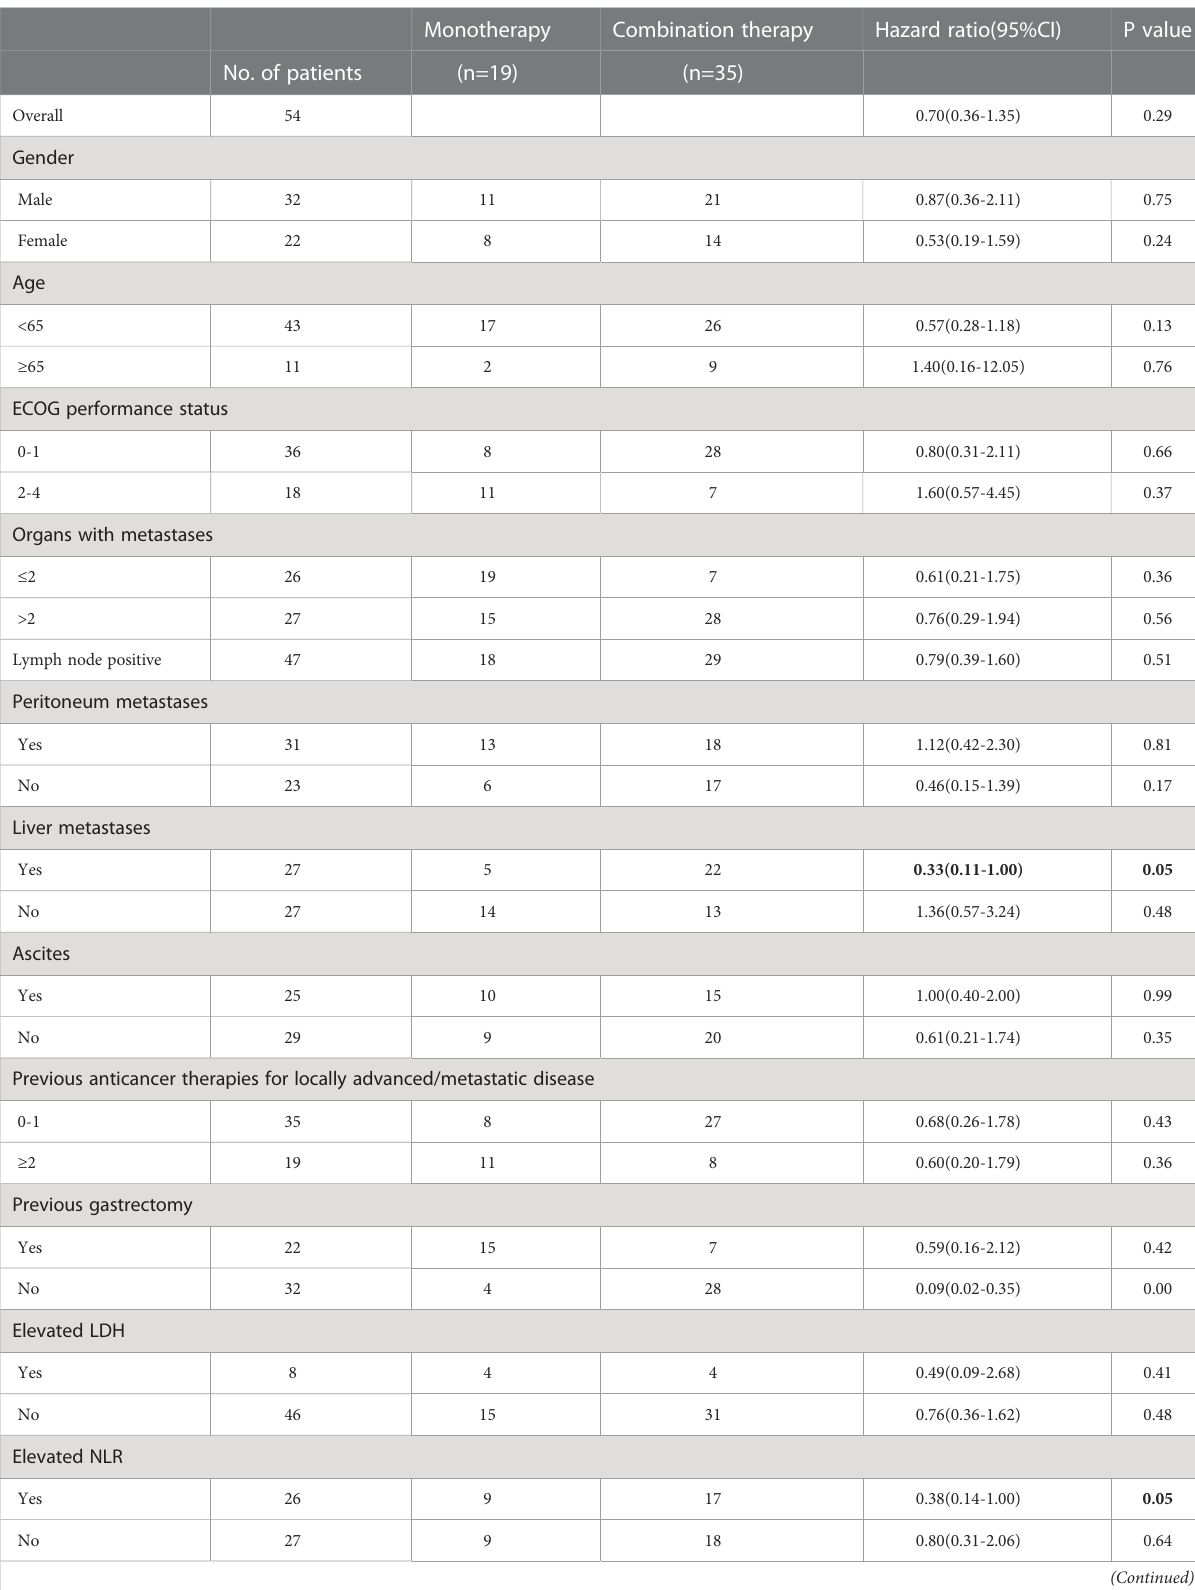
TABLE 4 Safety and treatment-related adverse